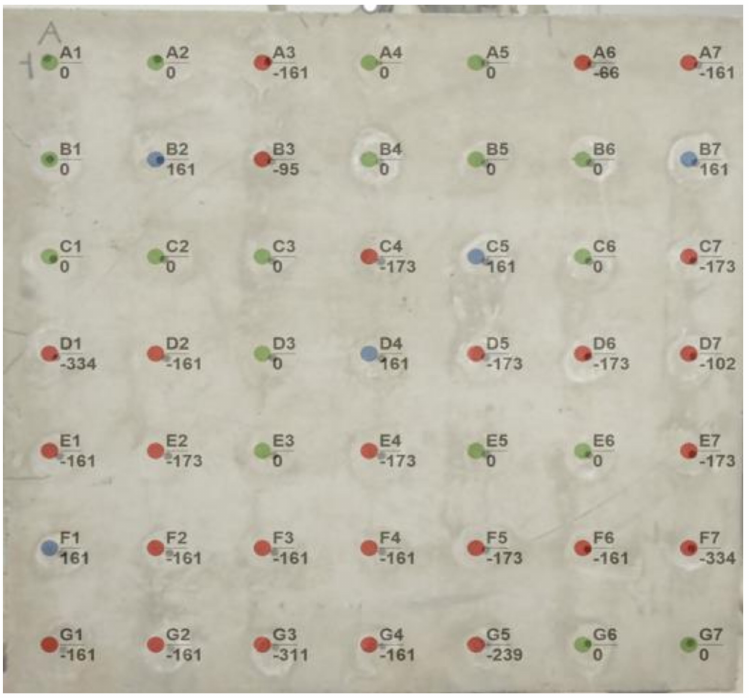
Figure 11. Schema of differences in measured velocities [m · s − 1 ] of ultrasound waves for specimen A2_2 before and after blast load of 350 g TNT: acceleration (red color)–42.9% of